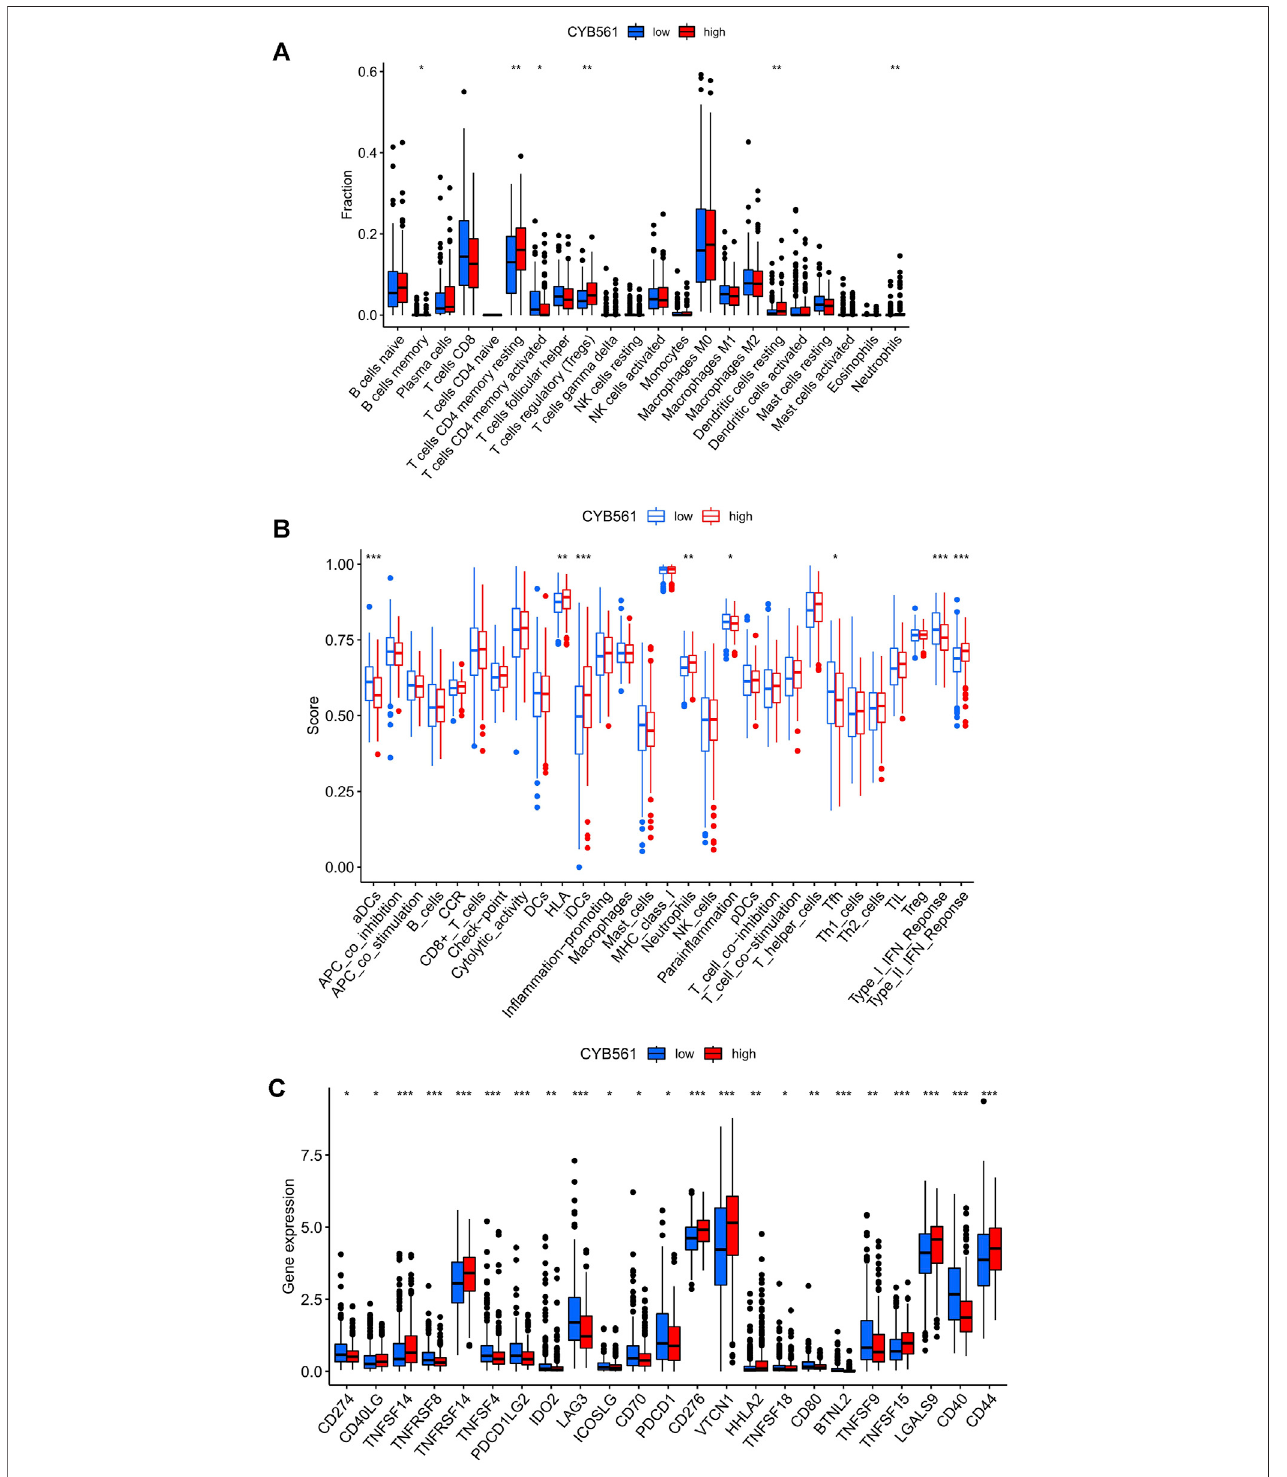
FIGURE 7 | Relationship between CYB561 expression and in fi ltrating immune cells in the UCEC tumor-immune microenvironment. (A) The box plot shows the proportiondifference ofeach immune cellbetweenthelow-and high-CYB561expression groups. (B) Thelandscape ofin fi ltrating immunecellsand immunefunctionin both groups. (C) The expression of CYB561 was associated with the key immune checkpoint genes in the UCEC microenvironment. The bottom and top of the boxes are the 25th and 75th percentiles (interquartile range). Blue: low risk, red: high risk. *** p < 0.001, ** p < 0.01, * p < 0.05.